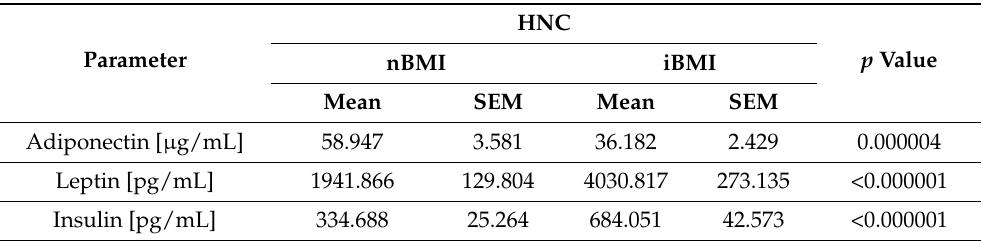
Table 2. Biochemical parameters with a statistically normal distribution analyzed in head and neck cancer (HNC) patients with respect to their body mass index (BMI).